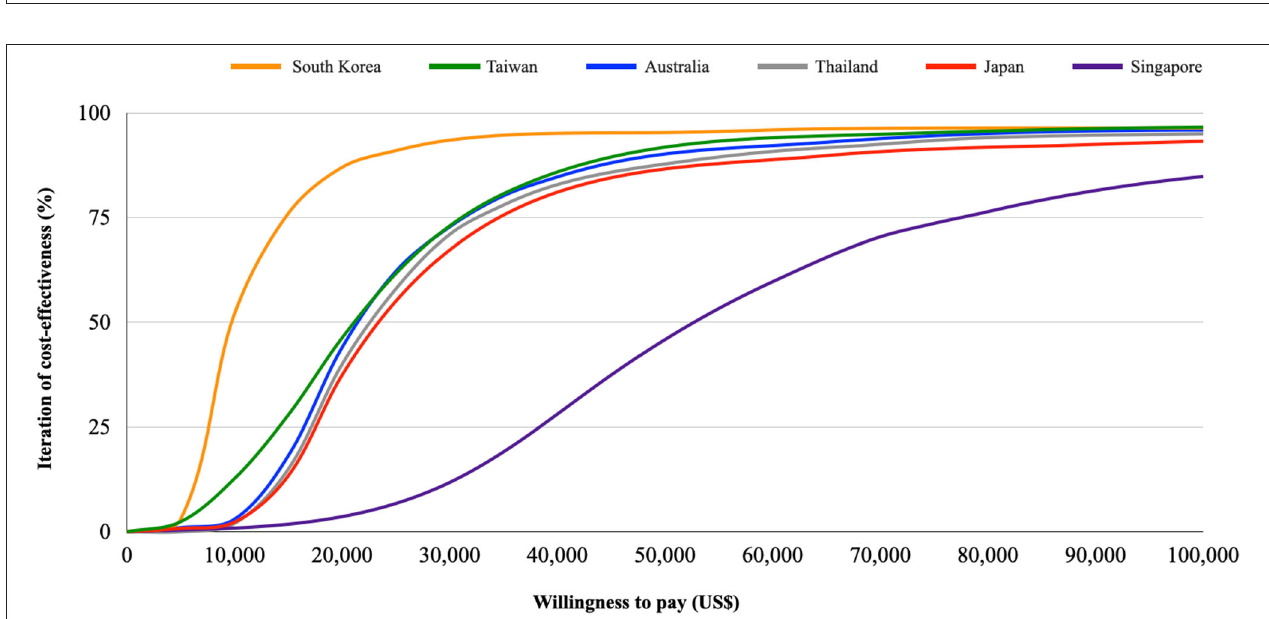
FIGURE 3 | Cost-effectiveness acceptability curve. Iterations of the cost-effectiveness of empagliflozin vs. placebo under different willingness to pay thresholds in Taiwan, Japan, South Korea, Singapore, Thailand, and Australia.